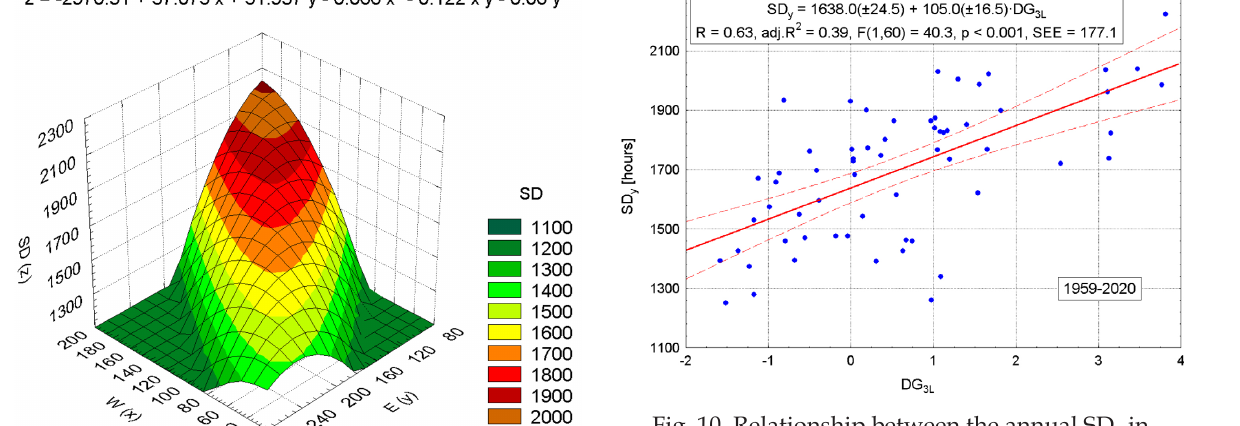
Fig. 10. Relationship between the annual SD in y Poznań and the DG index characterising the NA 3L THC intensity in the North Atlantic in 1959–2020. The regression line is marked with bold solid line and boundaries of confidence level of 95% ( p = 0.05) with dashed lines. NA THC, North Atlantic thermohaline circulation; SD, sunshine